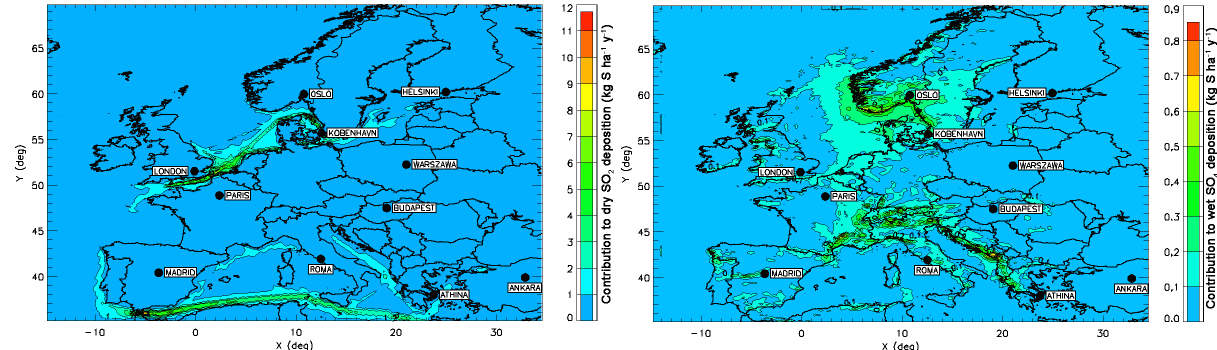
Figure 11. Contribution of ship emissions to dry SO 2 deposition (left) and wet SO 4 deposition (right) (base case − no